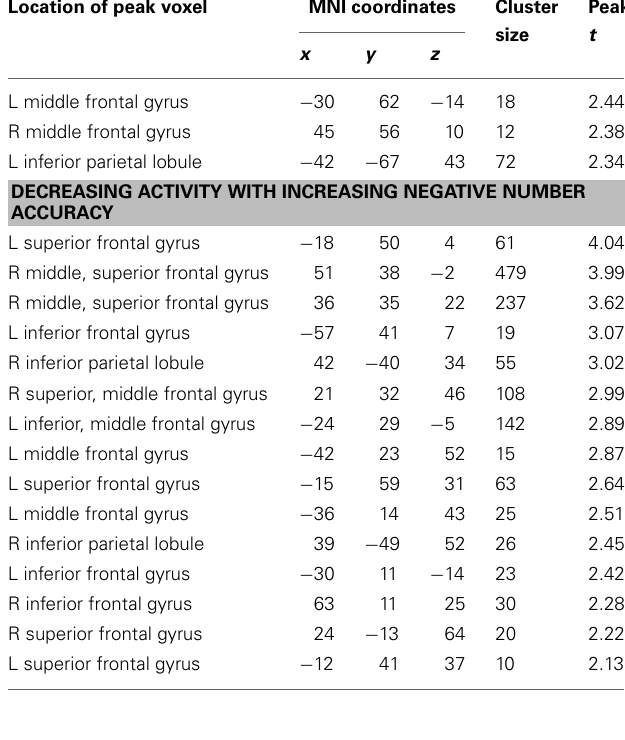
Table 7 | Covariate effects on the negative number distance effect across children.